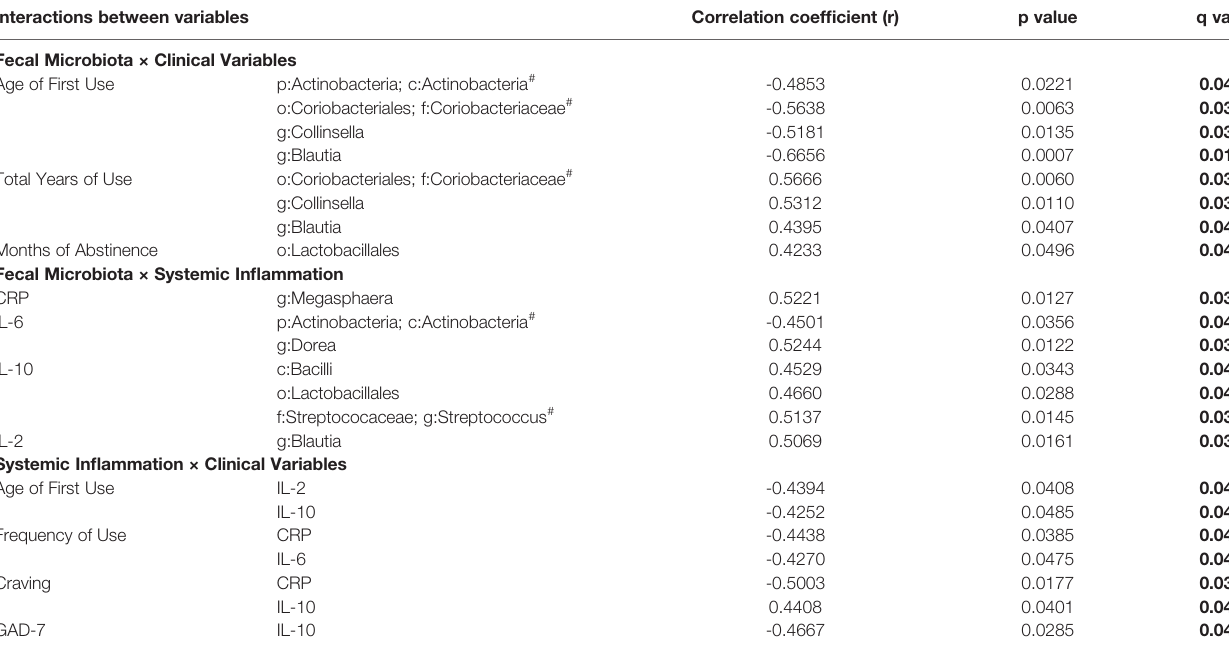
TABLE 3 | Correlations between altered fecal microbiota, clinical variables and markers of systemic in fl ammation. . Interactions between variables Correlation coef fi cient (r) p value q value